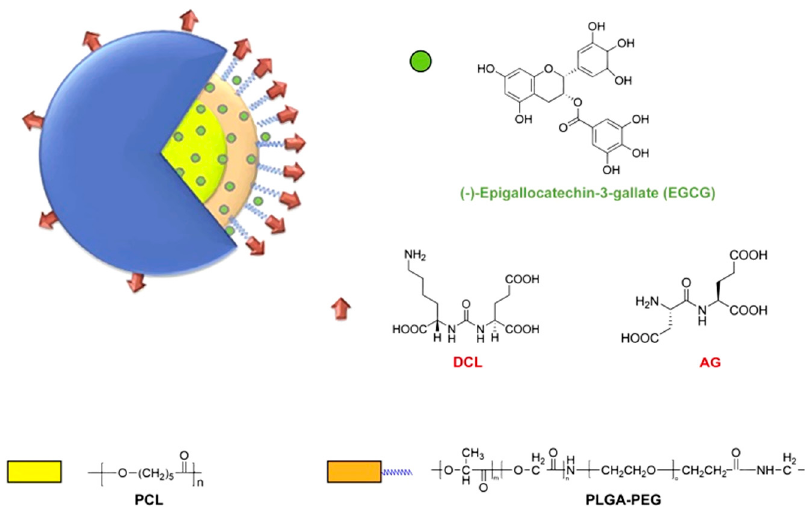
Figure 6. Schematic representation of the designed targeted EGCG NPs. Chemical structure of (-)- epigallocatechin-3-gallate (EGCG), the PEGylated PLGA polymers (PLGA-PEG), and the targeting ligands DCL and AG. Adapted from reference [213].